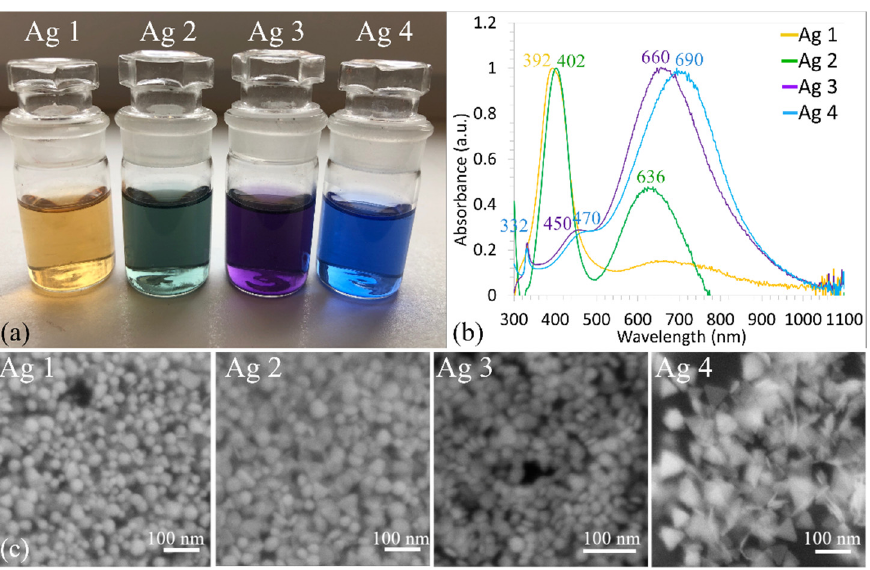
Figure 1. Color of AgNPs colloids immediately after preparation ( a ); UV-vis spectra of AgNPs colloids day 0 ( b ); and SEM images of sample Ag 1, 2, 3 and 4 ( c ).